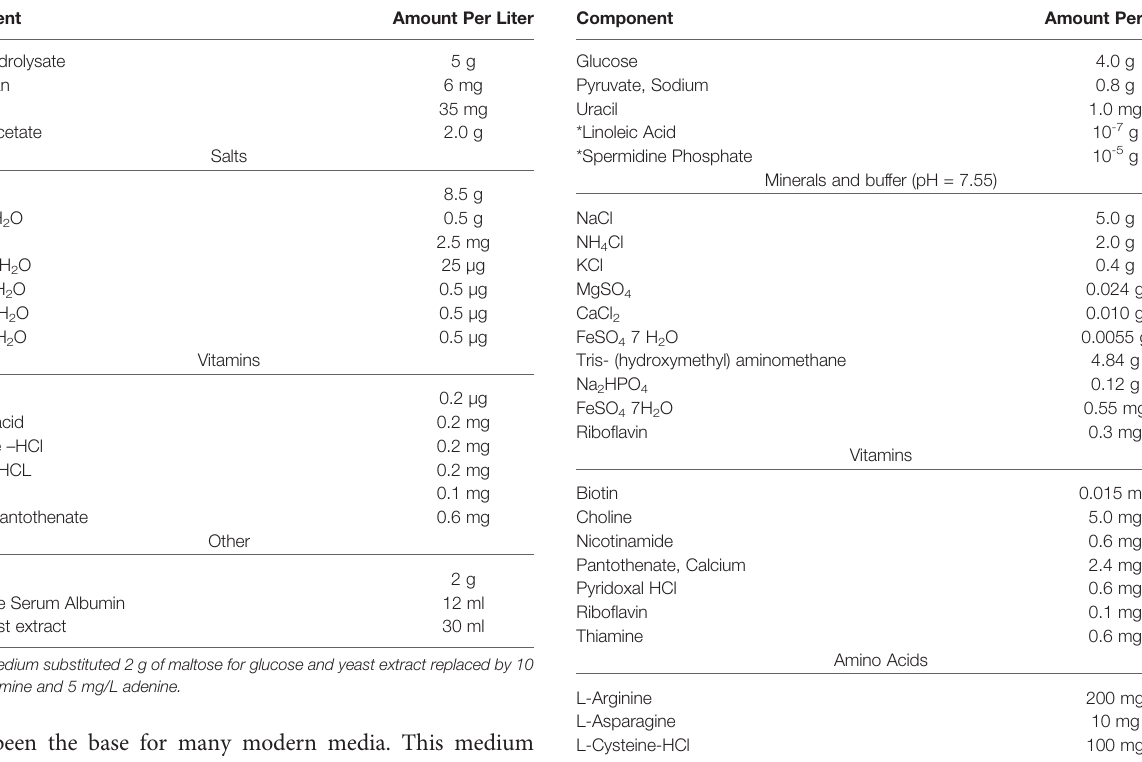
TABLE 6 | Lacks and Hotchkiss, 1960. TABLE 7 | Sicard,